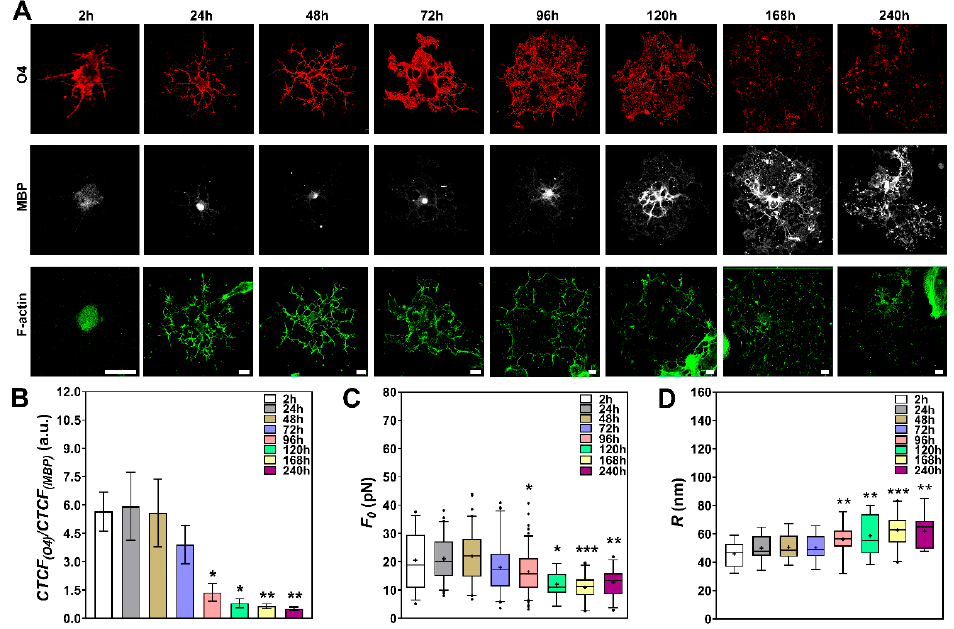
Figure 5. Tether extraction experiments and radius measurements for NPCs induced to differentiate into oligodendrocytes. ( A ) Representative images of cells stained for O4 (red), F-actin (green) and MBP (white) from 2 to 240h. Scale bars are all 10 μ m. ( B ) Ratio of O4 and MBP CTCF values over the course of differentiation from 2 to 240h. At least 10 different cells for each condition were imaged and analyzed in B. They all show similar behaviors as the ones represented in A. ( C–D ) Plots of tether force (at least 20 different cells) ( C ) and tether radius values (at least 12 different cells) ( D ) for each condition. The colored boxes extend from 25th to 75th percentiles, with a black horizontal line at the median and a black cross at the mean; black whiskers extend from 5th to 95th percentiles; values outside these ranges are plotted as individual points. * means p < 0.05, ** means p < 0.01, *** means p < 0.001 in Mann-Whitney U -test statistics when comparing each time point with the 2h condition. Another feature that appeared in the last hours of culture (168–240h) was the presence of spherical vesicle-like membrane protrusions stemming from the surface of oligodendrocytes (Figure 6A, images 1 and 2). These vesicles were previously documented several years ago in ultrastructural characterizations of cultured oligodendrocytes [36], but have apparently been neglected since that time.